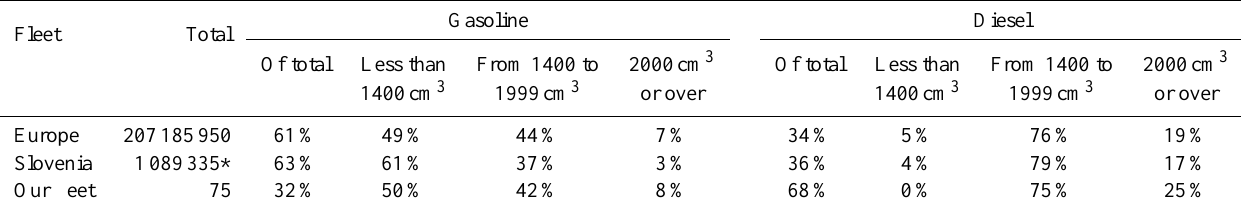
Table 3. Passenger car fleets according to the fuel used and engine displacement at the end of the year